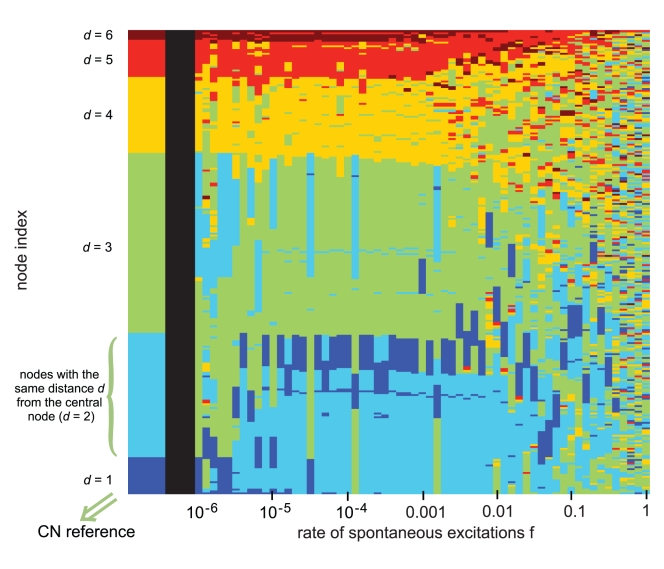
Dynamically detected clusters (DDC vectors) for 10−6<f<1 (right) re-sorted and colored according to the CN reference (left), as described in Figure 3.In this reference, the nodes sharing the same color have the same distance d to the central node h (see Figure 3 top row). Up to a value of f = 10−3, the equidistant nodes are almost completely integrated dynamically according to this topological reference. In this f-regime the dynamics is characterized by excitation waves (spikes), which cover the whole system and which emerge from h preferentially and independently of the location of the accidentally excited node. The increasing scattering of colors for higher values of f indicates a change of the dynamic regime, the spike dynamics is increasingly replaced by burst dynamics.